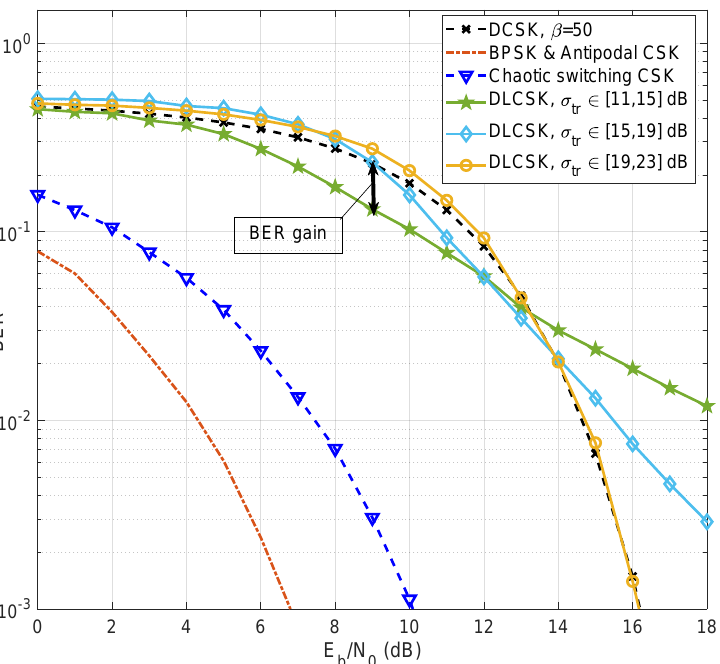
Figure 4. BER curve of the SISO DLCSK under AWGN channel for different [ σ tr , min , σ tr , max ] , β = 50, in comparison with the benchmark